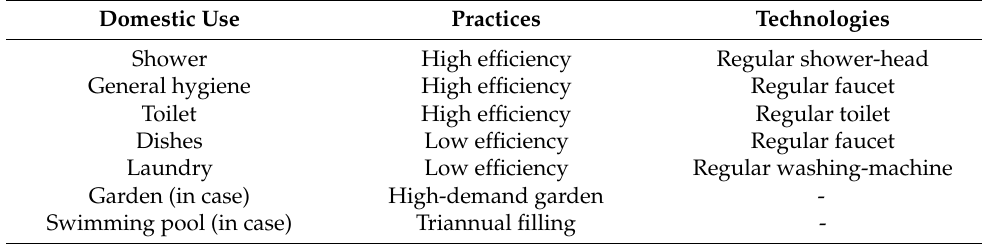
Table 5. Initialisation of practices and technologies of